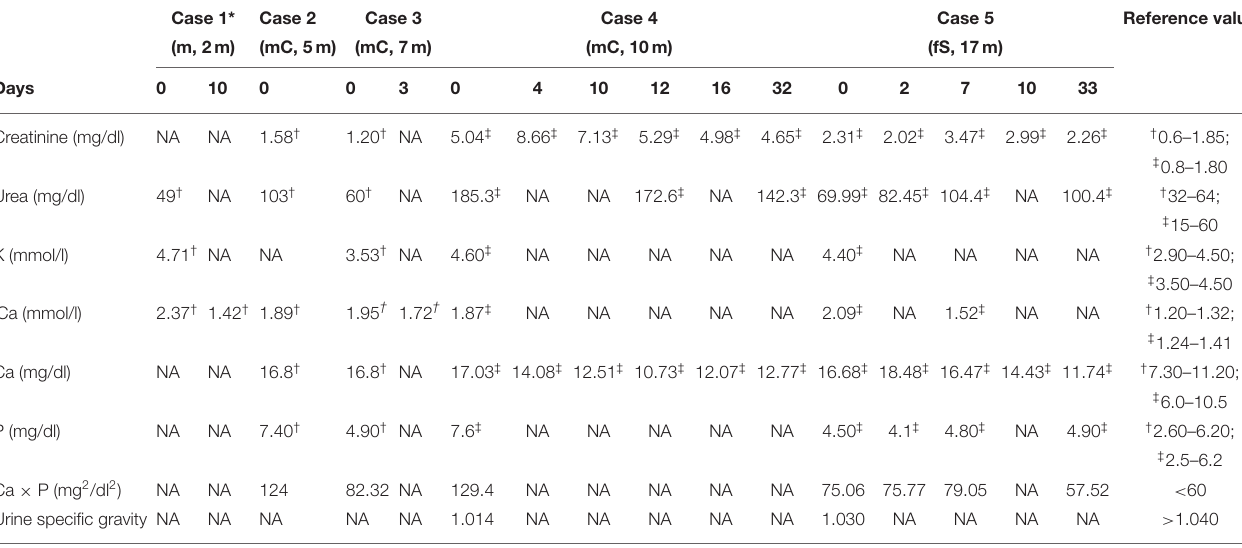
TABLE 1 | Results of selected blood parameters and urine specific gravity at first presentation and follow-up for cases 1, 3, 4, and 5 (the days since the first presentation are indicated). Case 1* Case 2 Case 3 Case 4 Case 5